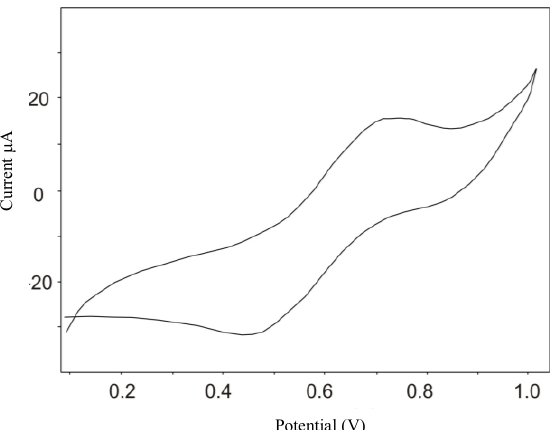
Figure 3a. The cyclic voltamogram of the complex I.